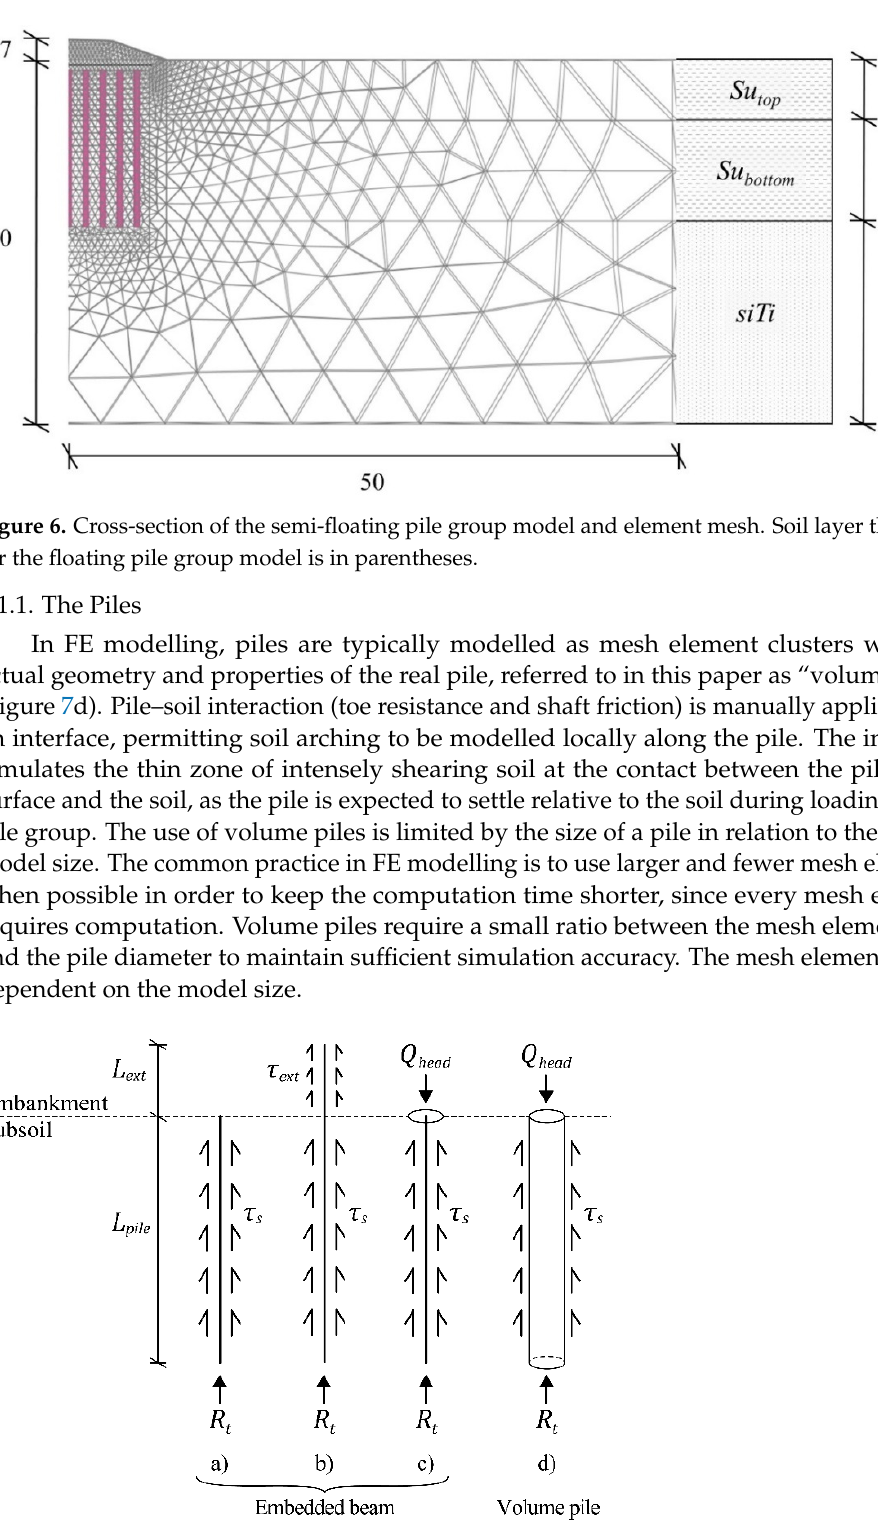
Figure 7. Illustration of ways of modelling piles: ( a ) embedded beam with pile head in level with the transition between embankment and subsoil; ( b ) embedded beam with an extension, length L ext , into the embankment with shaft resistance τ ext ; ( c ) embedded beam with a plate fixed to the node at the pile head; and ( d ) volume pile. 𝐿 (cid:3043)(cid:3036)(cid:3039)(cid:3032) is the pile length.